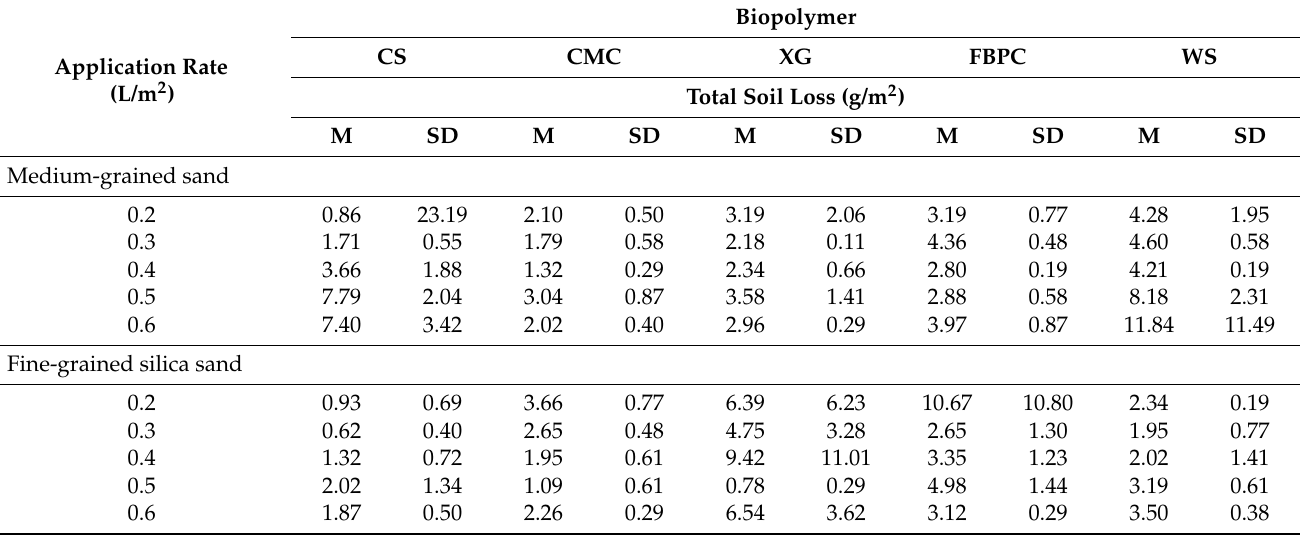
Table A2. Results of Phase 2 wind tunnel tests. Total wind-induced soil loss on medium-grained sand (Control; M = 2645.40 g/m 2 , SD = 783.60) and fine-grained silica sand (Control; M = 26,177.49 results of Phase